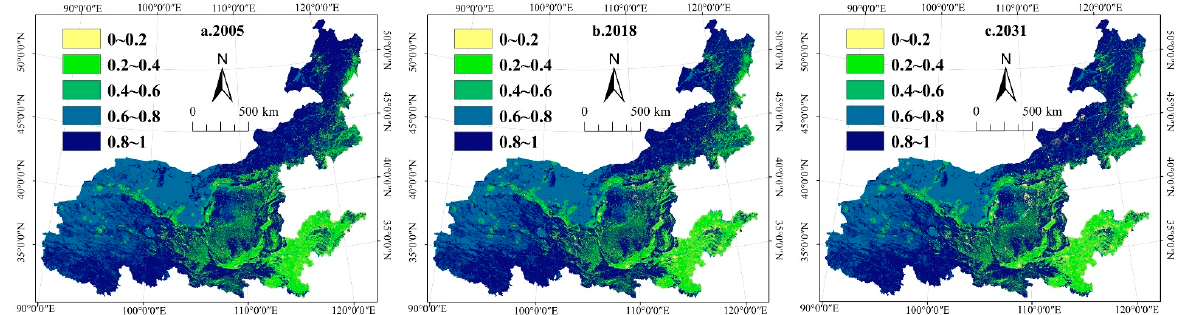
Figure 3. Distribution of habitat quality. ( a ). 2005 represents the habitat quality of the Yellow River Basin in 2005; ( b ). 2018 represents the habitat quality of the Yellow River Basin in 2018; ( c ). 2031 represents the habitat quality of the Yellow River Basin in 2031.